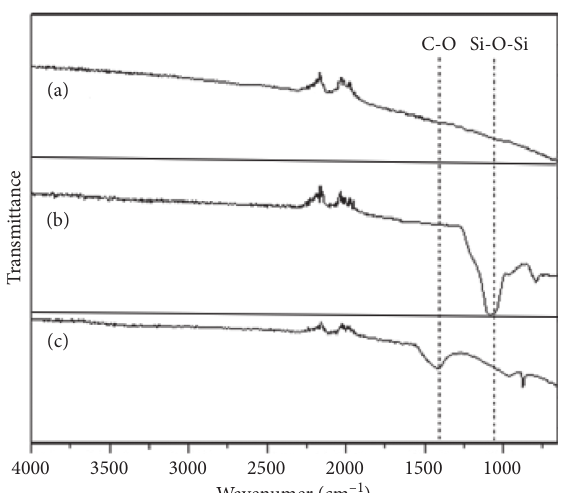
Figure 8: FT-IR spectrum of carbon fiber surface modified with different methods. (a) Plain carbon fiber. (b) Nano-SiO fiber. (c) C-S-H gel carbon